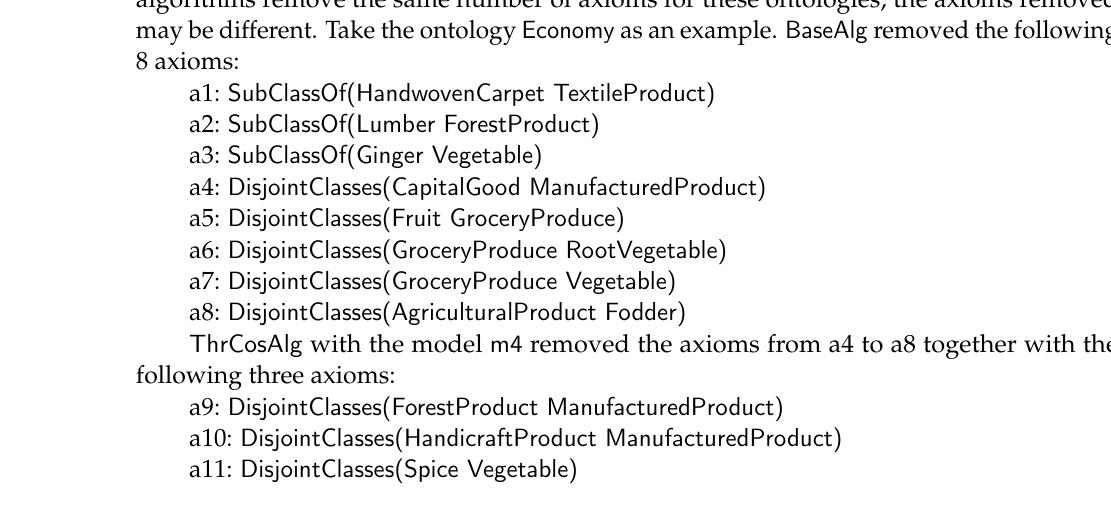
Table 5. Number of axioms removed by two threshold-based algorithms using different thresholds.